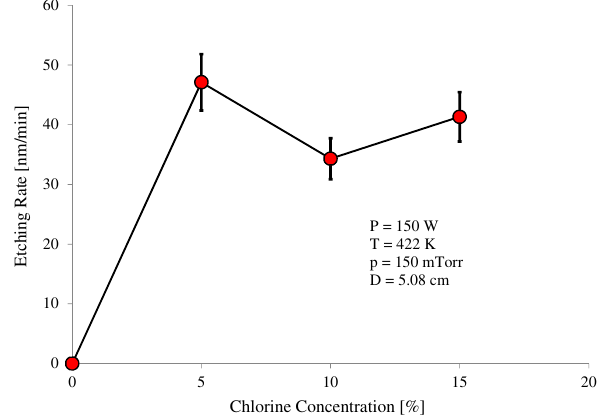
FIG. 10. Etching rate dependence on concentration of chlorine (% Vol) diluted in argon. Solid line is visual